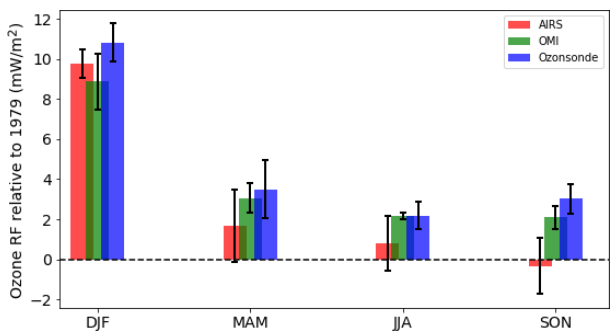
Figure 11. Seasonal average ozone UV radiative forcing (RF) rel- ative to 1979 as calculated from ozonesonde, OMI, and AIRS total ozone data for the 2011–2017 period. Spreads correspond to 1 stan- dard